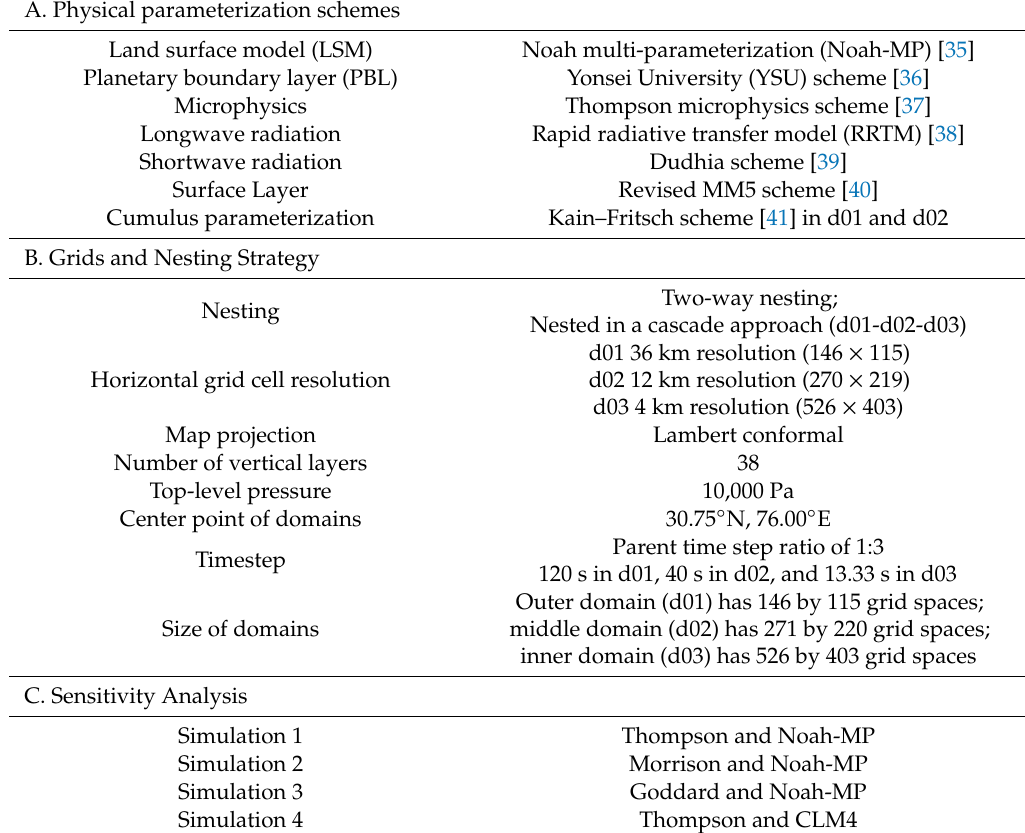
Table 1. Model strategy. d01, Domain